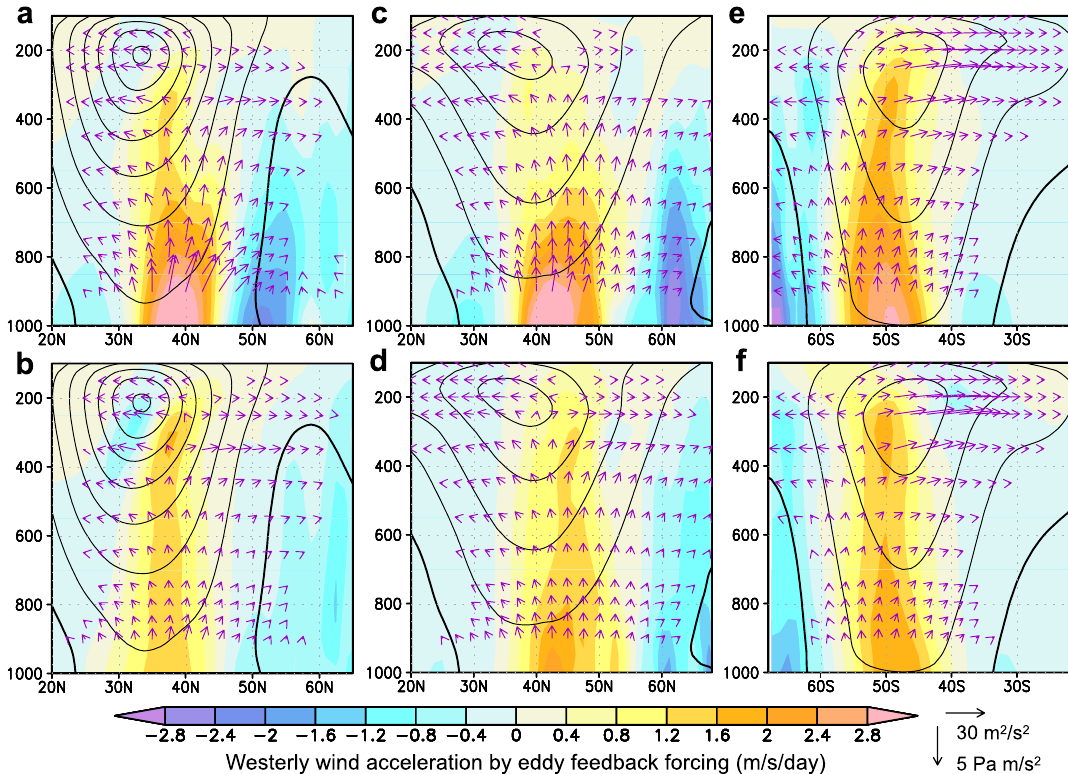
Figure 3. Westerly wind acceleration by transient feedback forcing evaluated separately for cyclonic and anticyclonic vortices. a-b, Meridional sections of climatological-mean net westerly wind acceleration or deceleration as transient eddy feedback forcing (colors) by cyclonic vortices ( a ) and anticyclonic vortices ( b ) for midwinter (24Jan). Quantities shown are zonally averaged for the western North Pacific [150°E − 180°]. Black contours denote climatological-mean westerly wind speed (every 10 m/s, thick line for 0 m/s). Vectors indicate extended E-P flux20 associated with cyclonic and anticyclonic vortices. ( c–d ), Same as in a-b, respectively, but for the storm track over the midwinter North Atlantic [80° − 50°W]. ( e – f ), Same as in a-b, respectively, but for the storm track over the midsummer South Indian Ocean [75° −